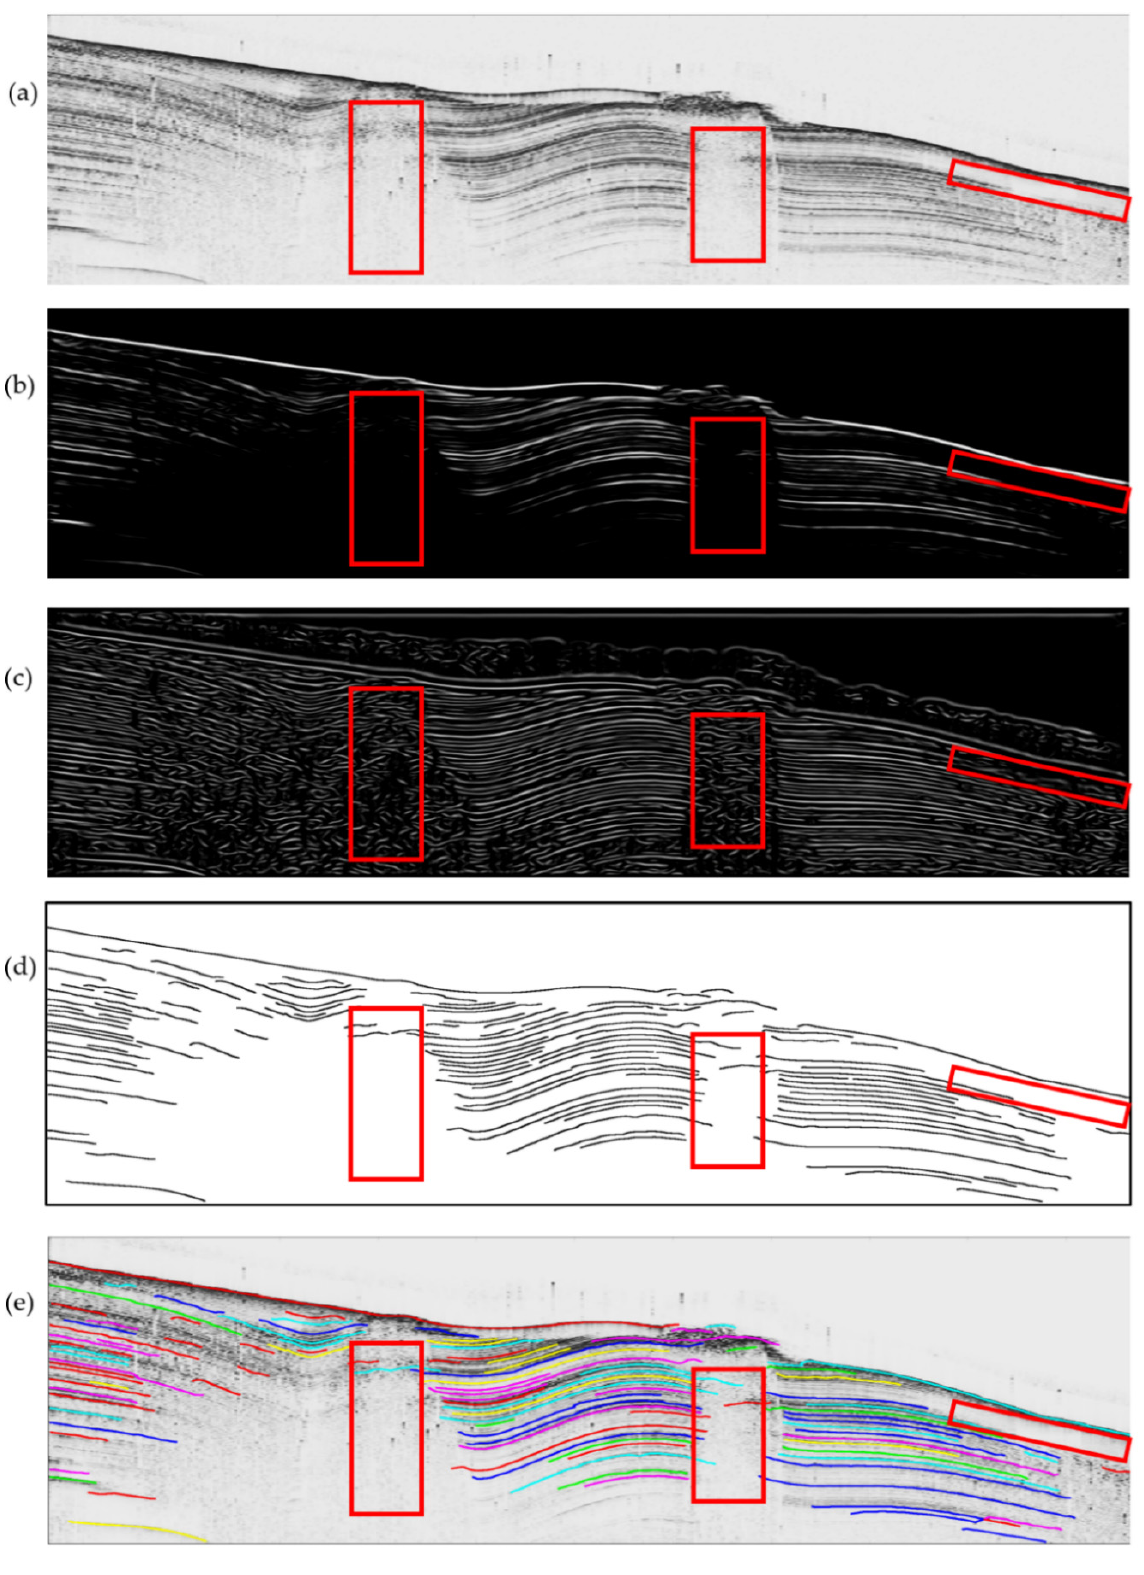
Figure 9. Processed results of SBP image. ( a ) shows the original SBP image. ( b ) the SBP image after enhancement filtering based on diffusion filtering result. ( c ) shows the SBP image after enhancement filtering based on local phase image. ( d ) shows the final horizons. ( e ) shows the superposition of picked horizons with the original SBP image. Horizon points belonging to the same horizon segment are assigned the same color.